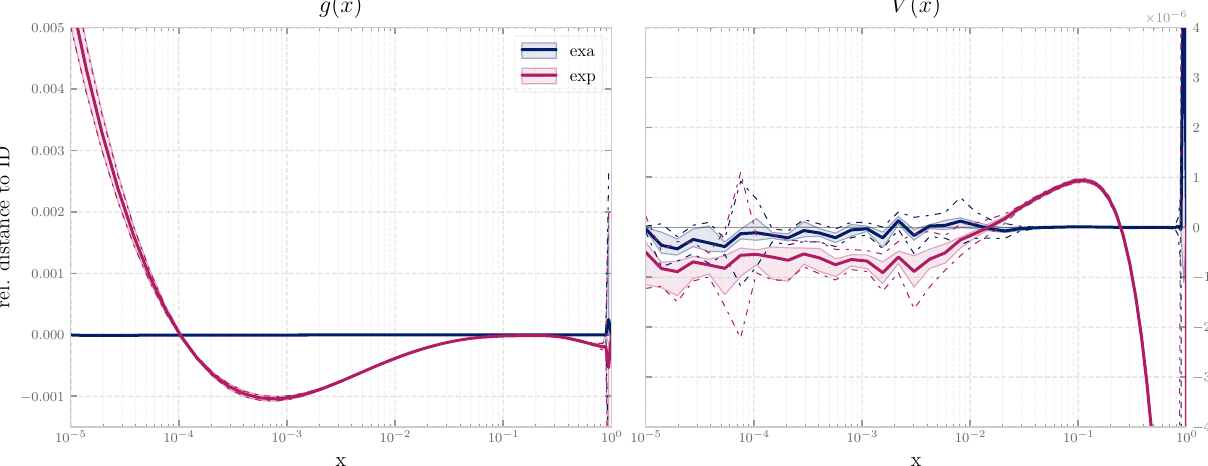
at 1 / 2 , 2 , and 5 times the bottom mass m 2 b = 1 . 65 2 → 10 4 GeV 2 F